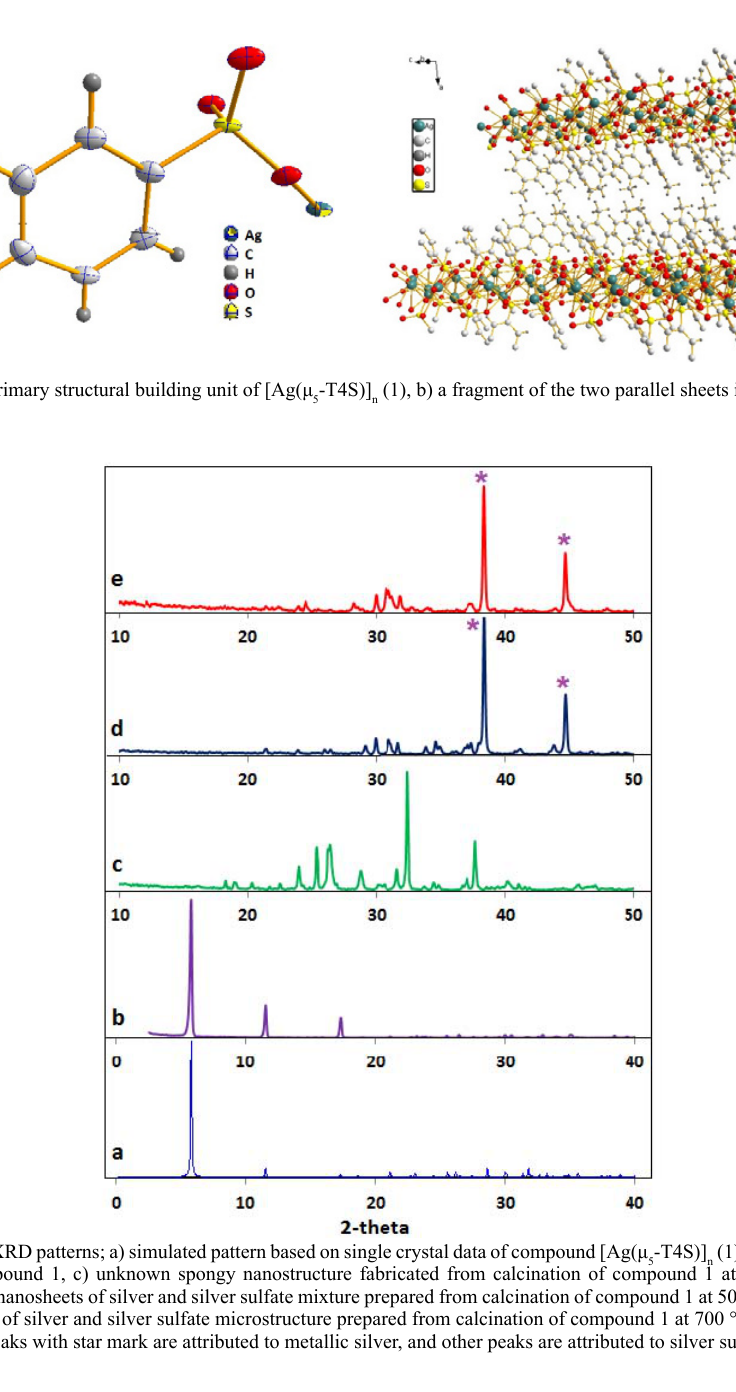
Fig. 2: XRD patterns; a) simulated pattern based on single crystal data of compound [Ag(μ of compound 1, c) unknown spongy nanostructure fabricated from calcination of compound 1 at 450 °C, d) packed nanosheets of silver and silver sulfate mixture prepared from calcination of compound 1 at 500 °C, and e) mixture of silver and silver sulfate microstructure prepared from calcination of compound 1 at 700 °C (assigned peaks with star mark are attributed to metallic silver, and other peaks are attributed to silver